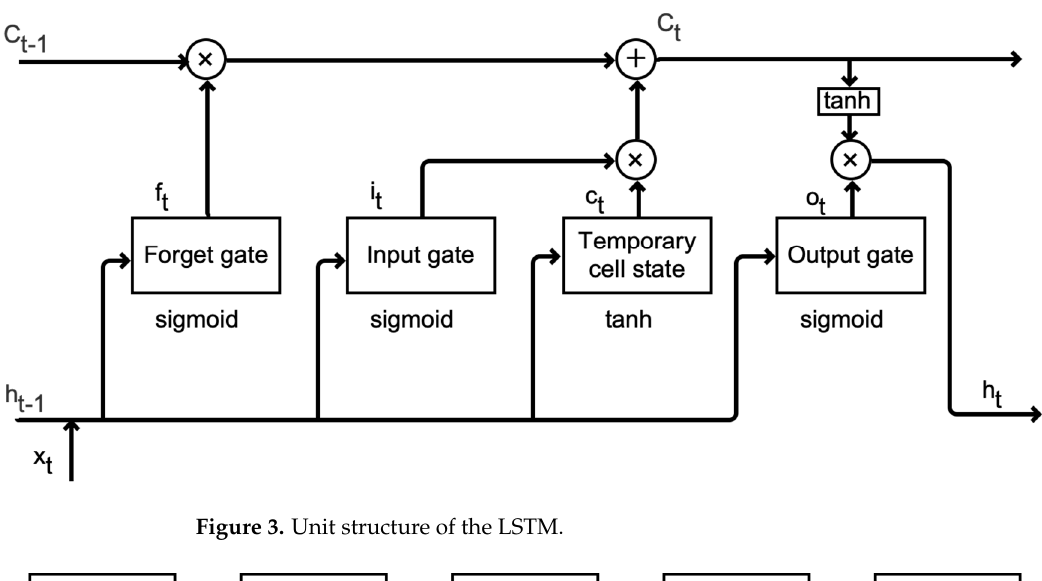
Figure 3. Unit structure of the LSTM.